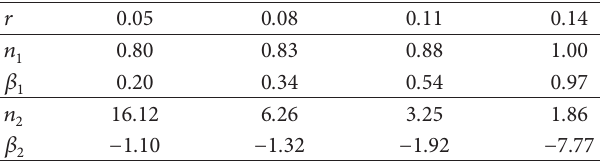
Table 2: The final results for the parameters n and 𝛼